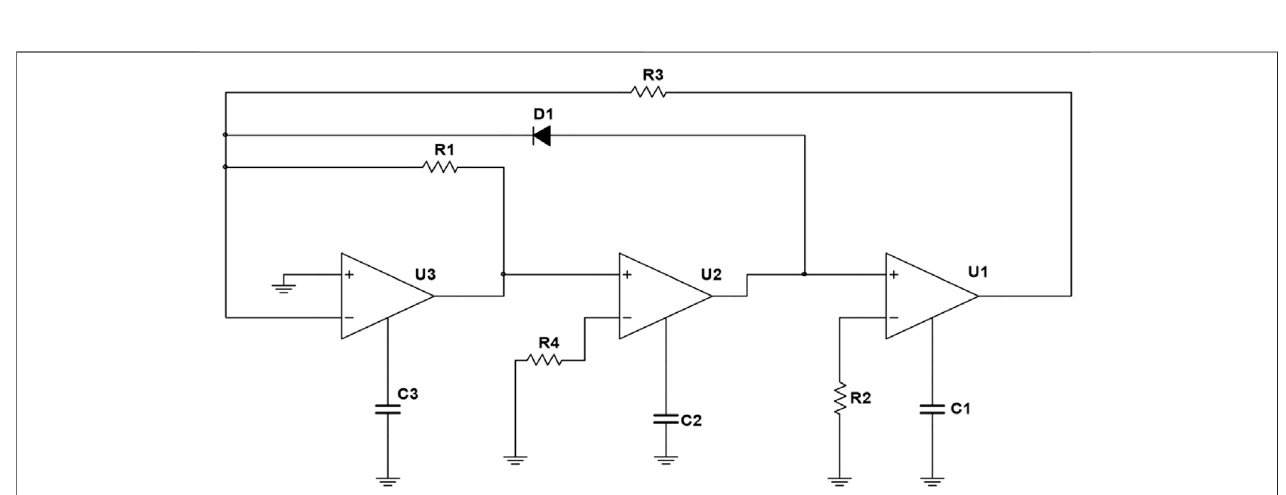
FIGURE 2 | The novel Jerk circuit with three CFOAs